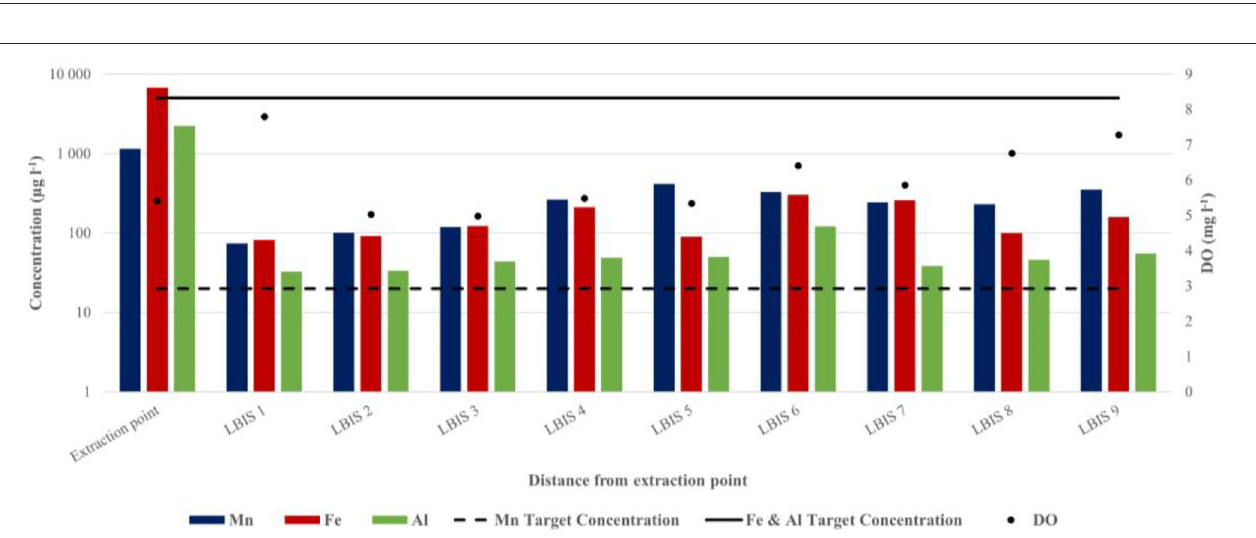
FIGURE 5 | Total Mn and Fe concentrations in water sampled at the LBIS 1 and LBIS 3 extraction points at 4.5 and 23km downstream from the dam wall, respectively (May 2016). The dotted and solid lines indicate target water quality guidelines in irrigation water for Mn and Fe, respectively.